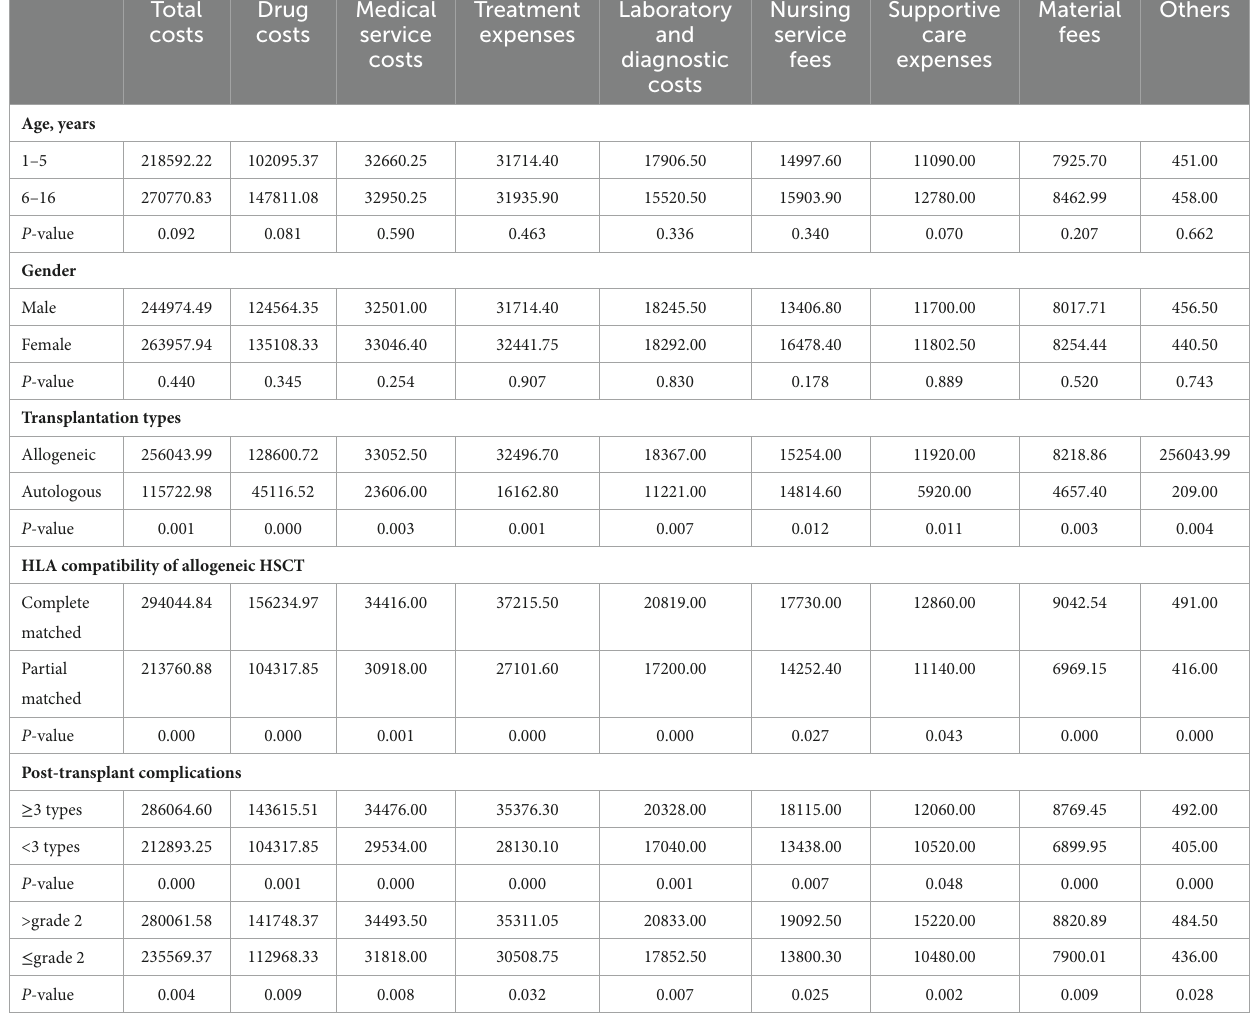
TABLE 3 Subgroup analysis of costs with hematopoietic stem cell